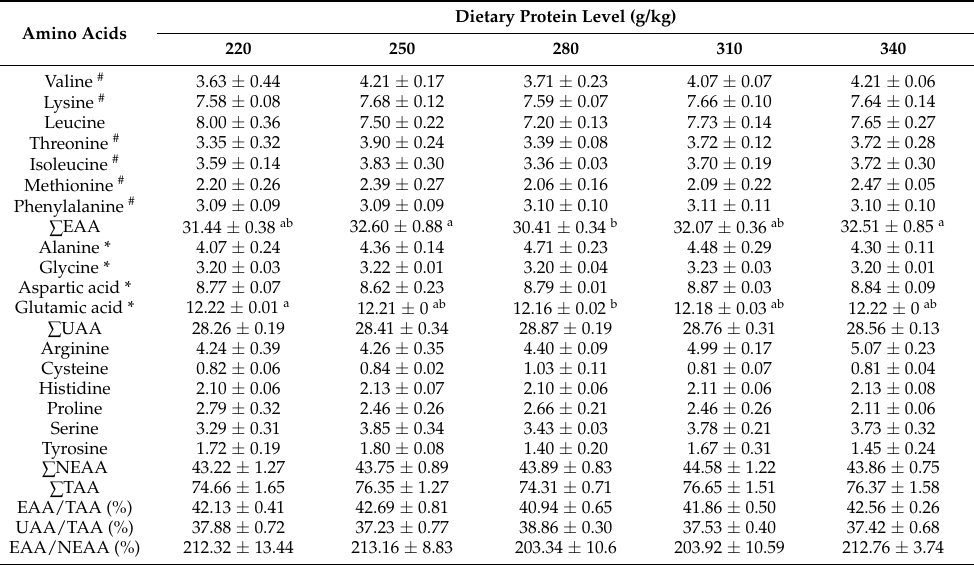
Table 6. Effects of different dietary protein levels on the amino acid profile of the muscle of Cyprinus carpio haematopterus (g/100 g, dry